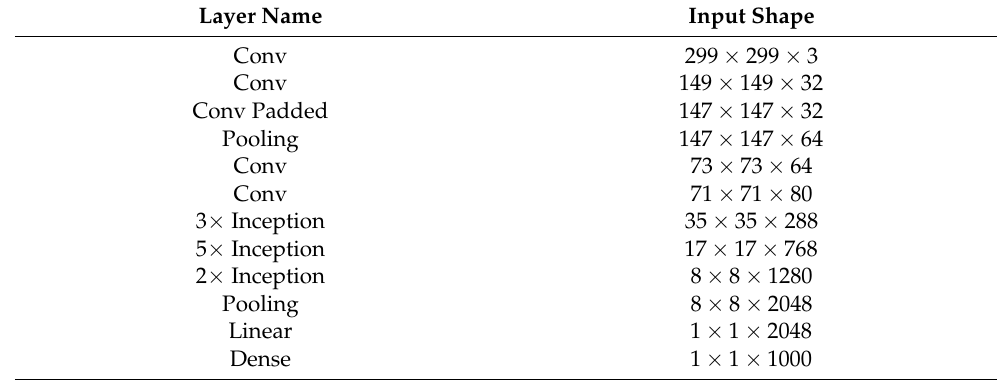
Figure 6. Architecture of InceptionV3 model [48]. Table 4. InceptionV3 layers.